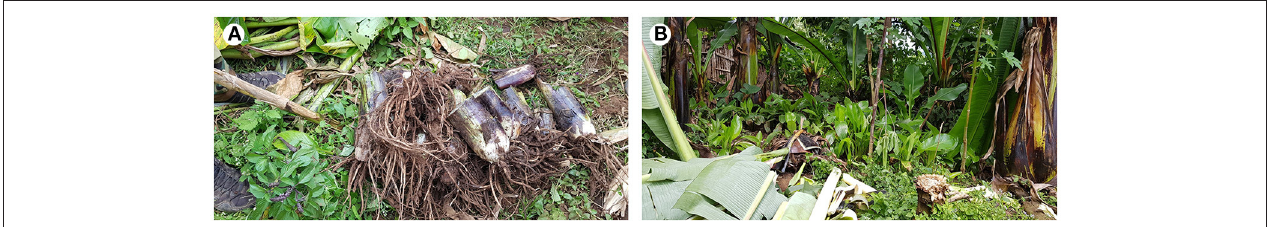
FIGURE 2 | Enset suckers collected from markets in Ethiopia.